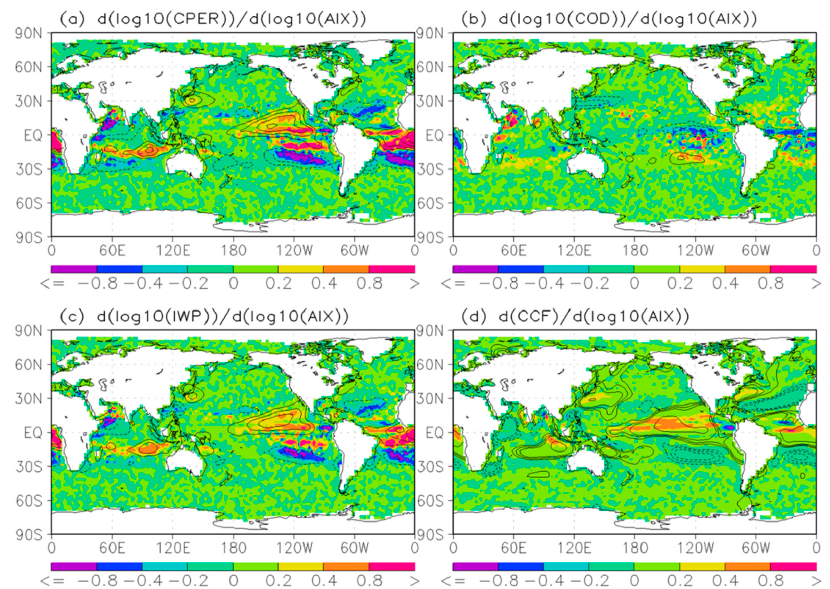
Figure 8. Global distributions of the sensitivity to AIX variation for ( a ) CPER, ( b ) COD, ( c ) IWP, and ( d ) CCF. The areas where the confidence level of positive and negative sensitivity above 95% are marked by the solid and dash contours, respectively.